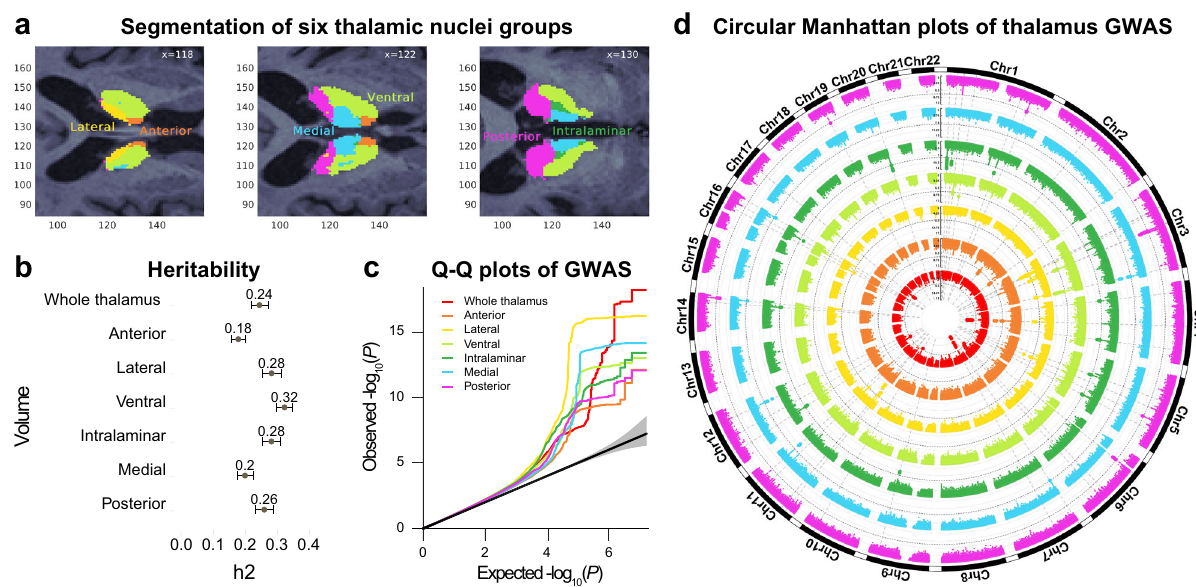
Fig. 1 Analysis of the GWAS discovery sample identi fi es 42 loci associated with thalamic volumes. a The thalamus was segmented into six nuclei groups — anterior, lateral, ventral, intralaminar, medial, and posterior nuclei — using Bayesian thalamus segmentation 16, 17 . All data sets were assessed by visually inspecting axial view fi gures of the segmentations for each participant and we removed sets with segmentation errors, insuf fi cient data quality, and pathologies. The nuclei volumes in the left and right thalamus were summed and these were used in the analyses. b Heritability estimates for the thalamic volumes in the discovery sample of n = 30,114 participants from the UK Biobank. All thalamic volumes showed substantial heritability. Data are presented as mean ± SE. c Q – Q plots for the thalamic volumes of the discovery sample. d Circular Manhattan plots of GWAS for thalamus volumes of the discovery sample. The innermost plot re fl ects the GWAS of whole thalamus volume, whereas from center to the periphery, the plots indicate the GWAS of the anterior, lateral, ventral, intralaminar, medial, and posterior nuclei, respectively. Black circular dashed lines indicate genome-wide signi fi cance (two-sided P < 7e − 9). Horizontal Manhattan plots for the seven volumes are shown in Supplementary Fig. 2. The colors in a , c , and d indicate the same volumes, i.e., red color re fl ects whole thalamus; orange, yellow, and light green indicate the anterior, lateral, and ventral nuclei, respectively; whereas dark green, blue, and magenta re fl ect intralaminar, medial, and posterior nuclei volumes, respectively. GWAS, genome-wide association studies; h2,